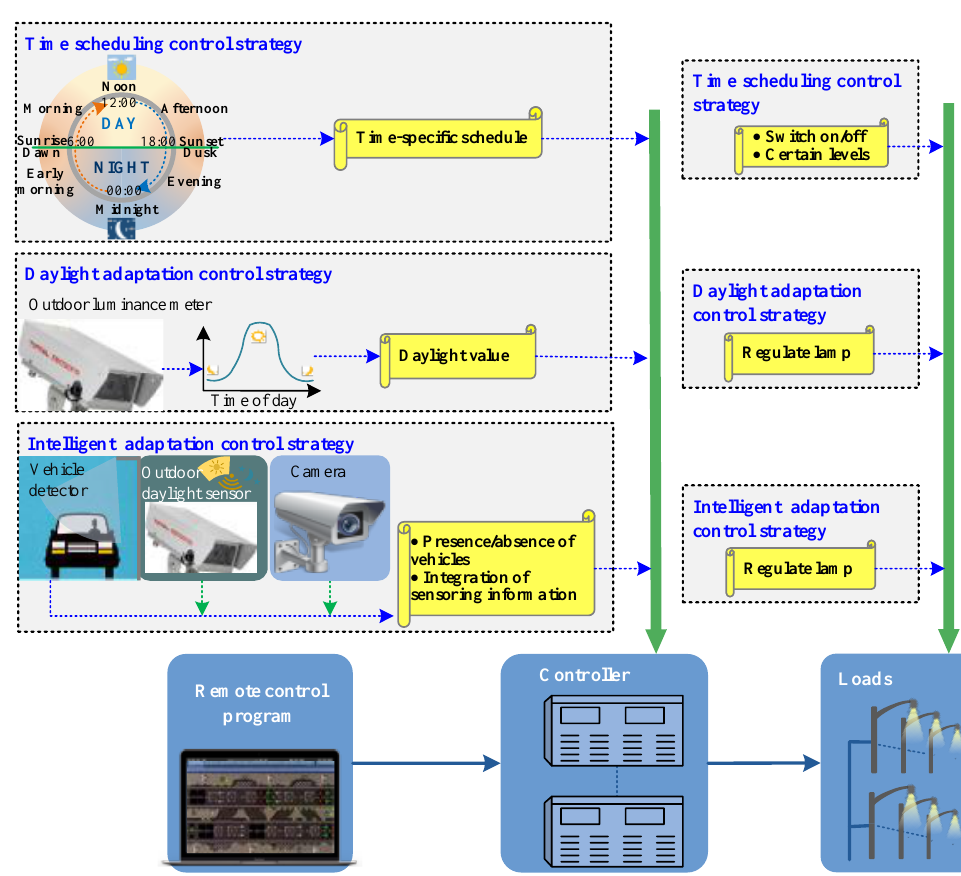
Figure 2. Time scheduling, daylight adaptation, and intelligent control schemes.